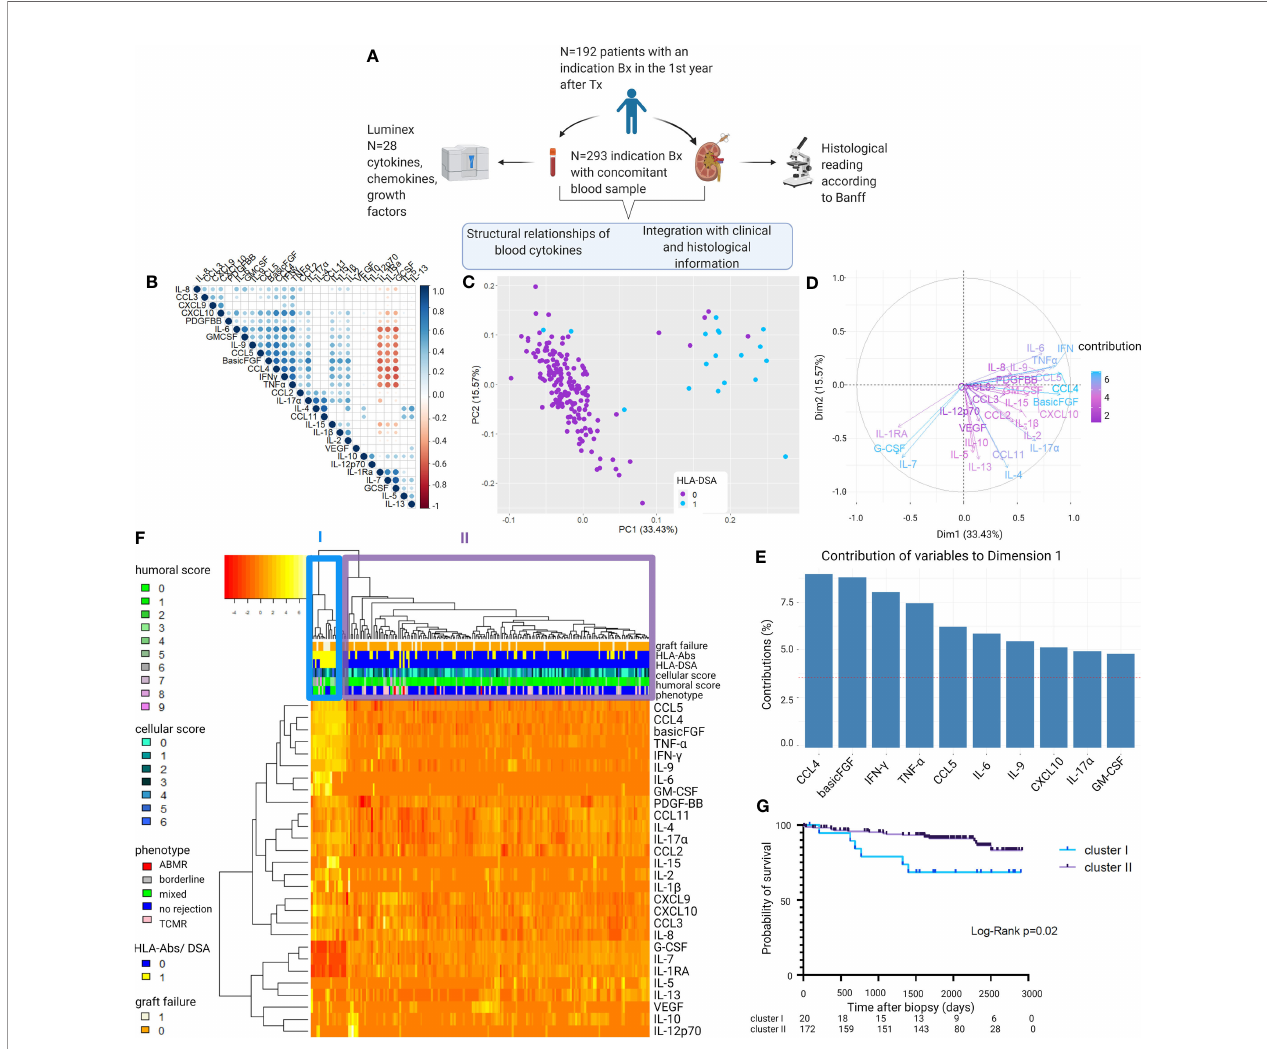
FIGURE 1 | Visualization of the structural relationships between blood protein levels and clinical and histological characteristics. (A) Study design. (B) Correlation matrix of the 28 proteins using Pearson correlations of the log10-transformed protein levels. Colors indicate correlation coef fi cient ( r ); dots indicate p-values (only p-values <0.05 are represented with a circle). Proteins are ordered as de fi ned by hierarchical clustering. (C) Principal component analysis (PCA) of fi rst biopsies per patient (N = 192) shows two clusters distinct in their 28 blood protein levels. Colors indicate the presence of HLA-DSA. (D) Contributions of the 28 cytokines to the principal component analysis. (E) Top 10 contributing cytokines to axis 1 of the principal component analysis (PC1). (F) Heatmap analysis of histological lesions and blood proteins of fi rst biopsies per patient (N = 192). Reordering of dendrograms based on hierarchical clustering. Two distinct clusters, cluster I (N = 20) and II (N = 172) can be distinguished. (G) Kaplan – Meier survival curve illustrating survival probability for cluster I and II, counted from the day of the fi rst biopsy (N = 192). ABMR, antibody-mediated rejection; TCMR, T cell-mediated rejection; HLA-DSA, anti-HLA donor-speci fi c antibodies; HLA-Abs, anti-HLA antibodies. Mixed rejection was de fi ned as ABMR concomitant with TCMR or borderline changes. All protein levels are log10 transformed. Humoral score = sum of glomerulitis; peritubular capillaritis, intimal arteritis and C4d deposition in the peritubular capillaries. Cellular score = sum of tubulitis, interstitial in fl ammation, and intimal